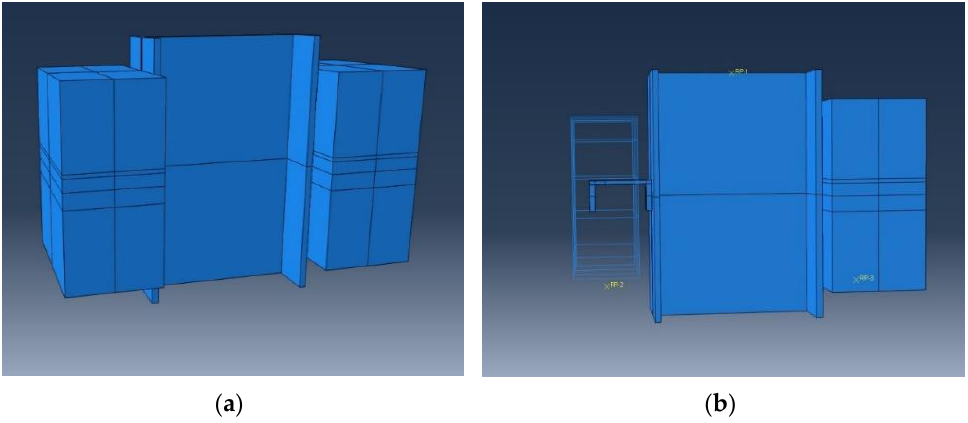
Figure 4. The sketched 3D model in ABAQUS: ( a ) exterior view and ( b ) inner cut.